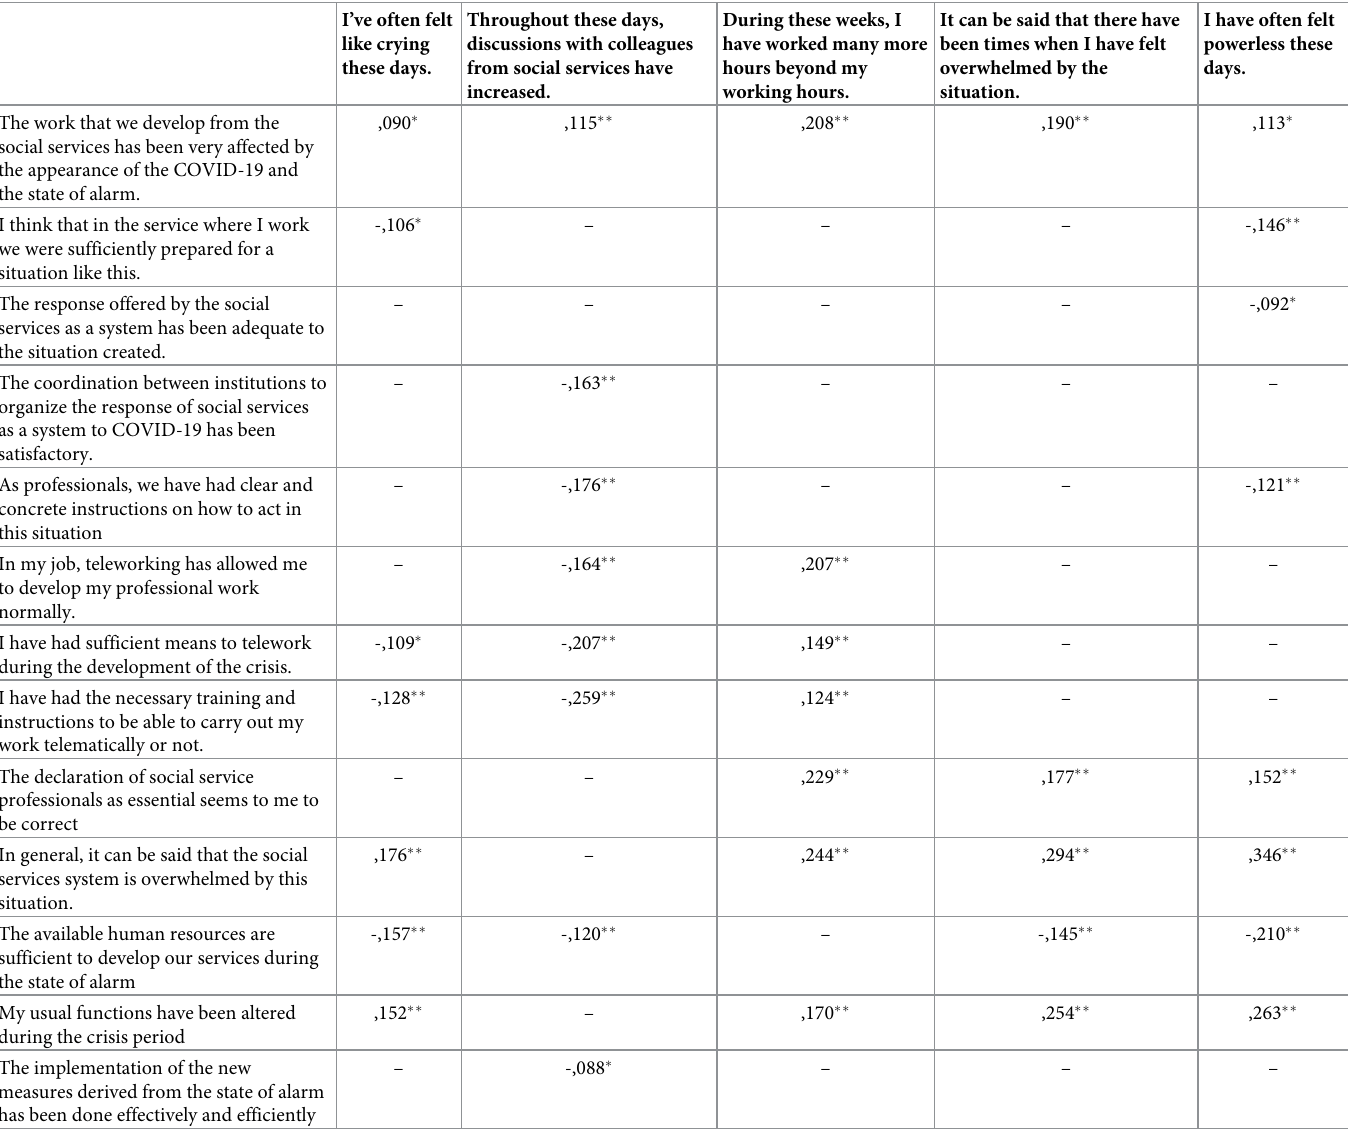
Table 7. Correlations between feeling overwhelmed by the situation and affecting professional functions.